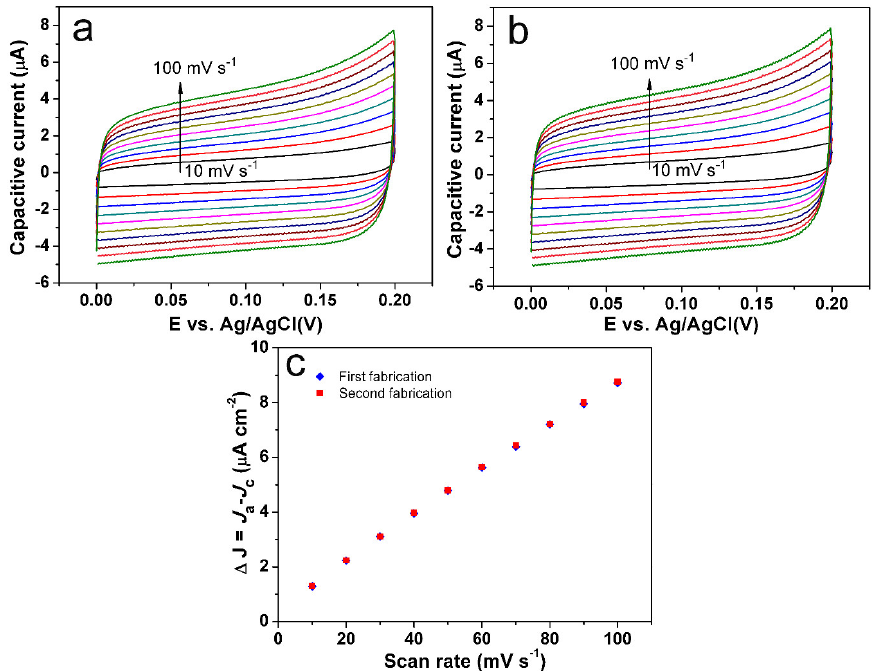
Figure 10. Cyclic voltammograms with different scan rates in the potential range of 0.0 V to 0.2 V vs. Ag/AgCl, where no Faradaic processes occur for the first ( a ) and second fabrication ( b ) of the electrode. against scan